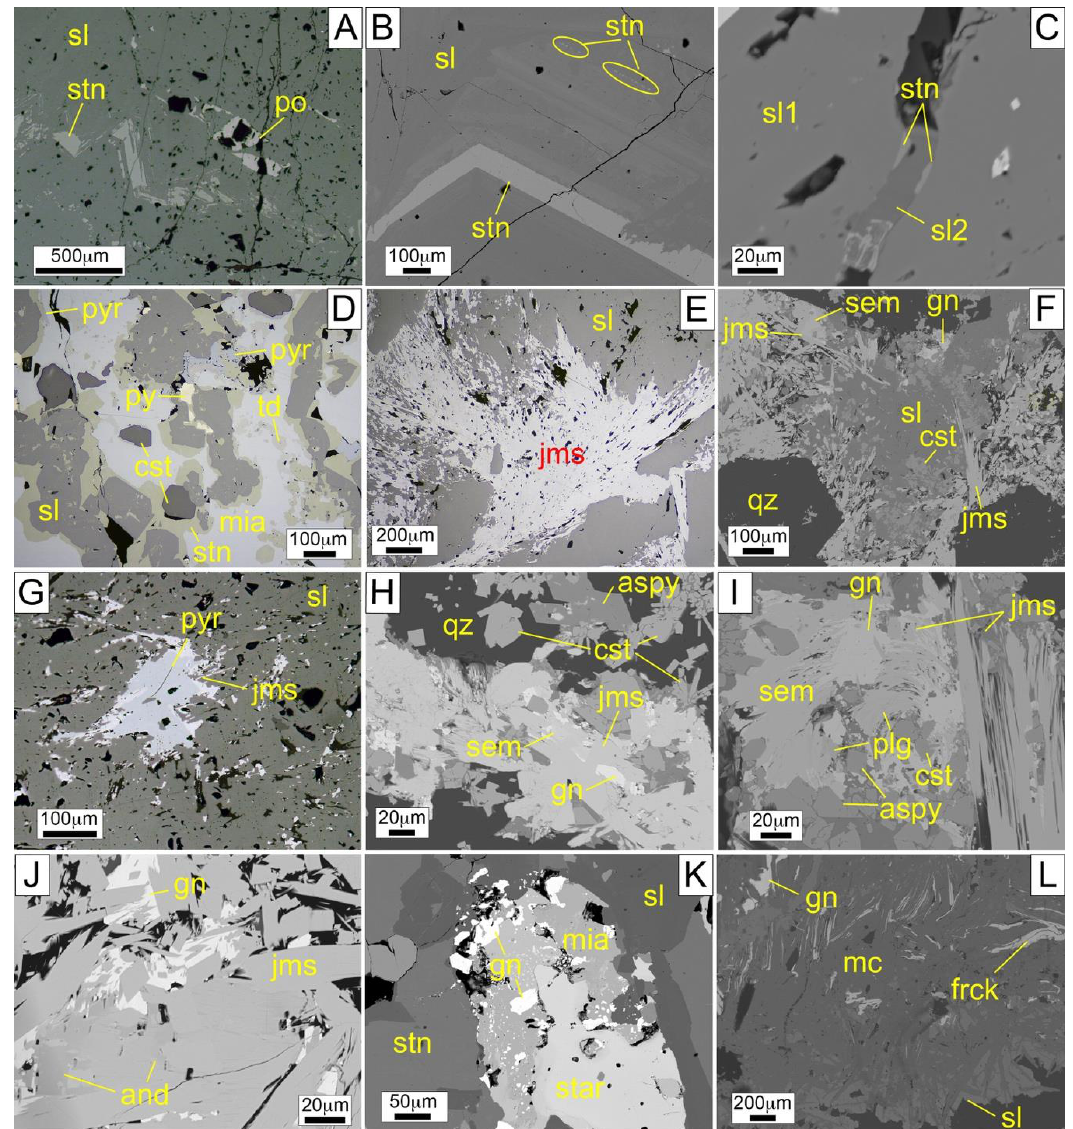
Figure 6. Photomicrographs of representative polymetallic vein mineralization in the Huari Huari district. ( A ) Oscillatory-zoned stannite – sphalerite; remnants of pyrrhotite are strongly replaced by sphalerite (reflected light). ( B ) Detail of the oscillatory zoning of stannite and sphalerite; note the different brightness in sphalerite that points out zoning within this mineral as well. An outer band of sphalerite partially replaced the one of stannite, thus suggesting that both minerals formed alternately in time, and that the latter was not an exsolution from the former (backscattered electron image, BSE). ( C ) A first generation of sphalerite (sl1) is veined by a second generation of sphalerite (sl2); the contact between both served as a collector for stannite (BSE). ( D ) Complex texture in which corroded sphalerite is wrapped by stannite (which also lined vugs within this phase) and an interstitial overgrowth of miargyrite and argentian tetrahedrite. Pyrargyrite is mostly located along the contacts between stannite and miargyrite or tetrahedrite (reflected light). ( E ) Intergrowth between jamesonite bundles and sphalerite (reflected light). ( F ) Interstitial to quartz crystals, bladed and feathery jamesonite crystals gave way to an intergrowth of cassiterite and sphalerite. Semseyite was partially replaced by jamesonite (BSE). ( G ) Zonal arrangement of sphalerite, jamesonite, and pyrargyrite; notice that the porosity within sphalerite shows bladed morphologies similar to those of jamesonite remnants, probably related to dissolution of early jamesonite, and that such porosity was partially lined by pyrargyrite (reflected light). ( H ) An early assemblage of quartz, arsenopyrite, and cassiterite is veined by jamesonite.